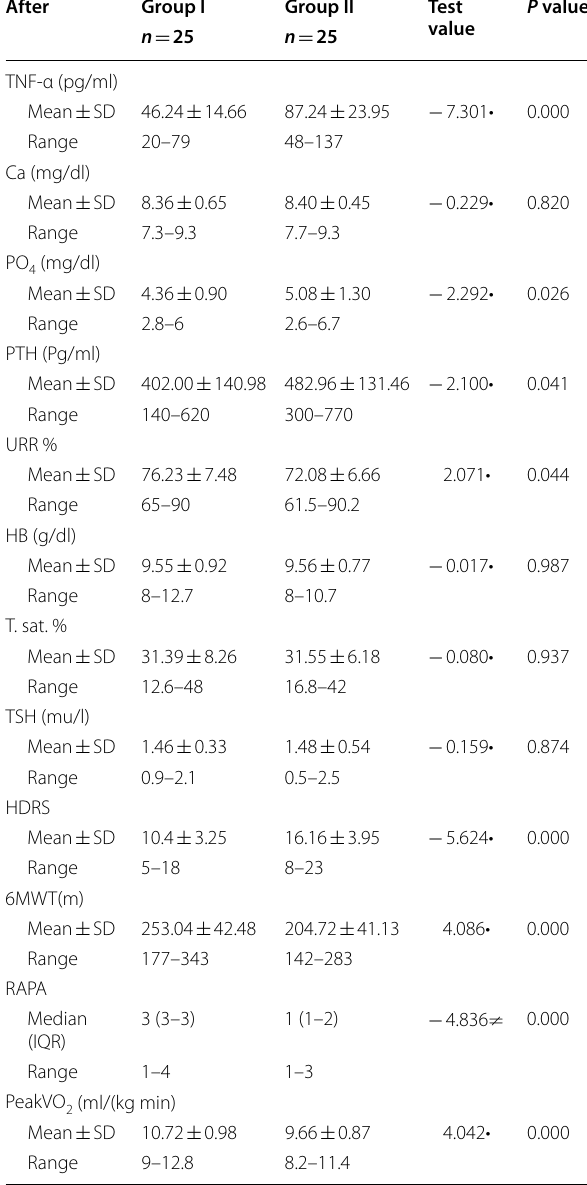
Table 3 Comparison between group I and group II at the end of the study as regard the studied parameters